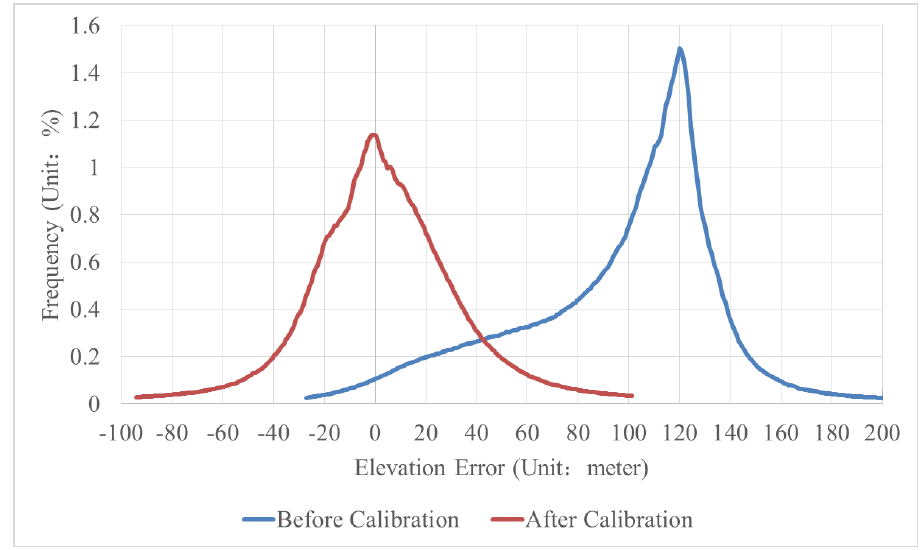
Figure 11. Elevation error with the high-accuracy GCF. ( a ) A systematic error in the DSM before calibration, ( b ) the error is random in the DSM after calibration.